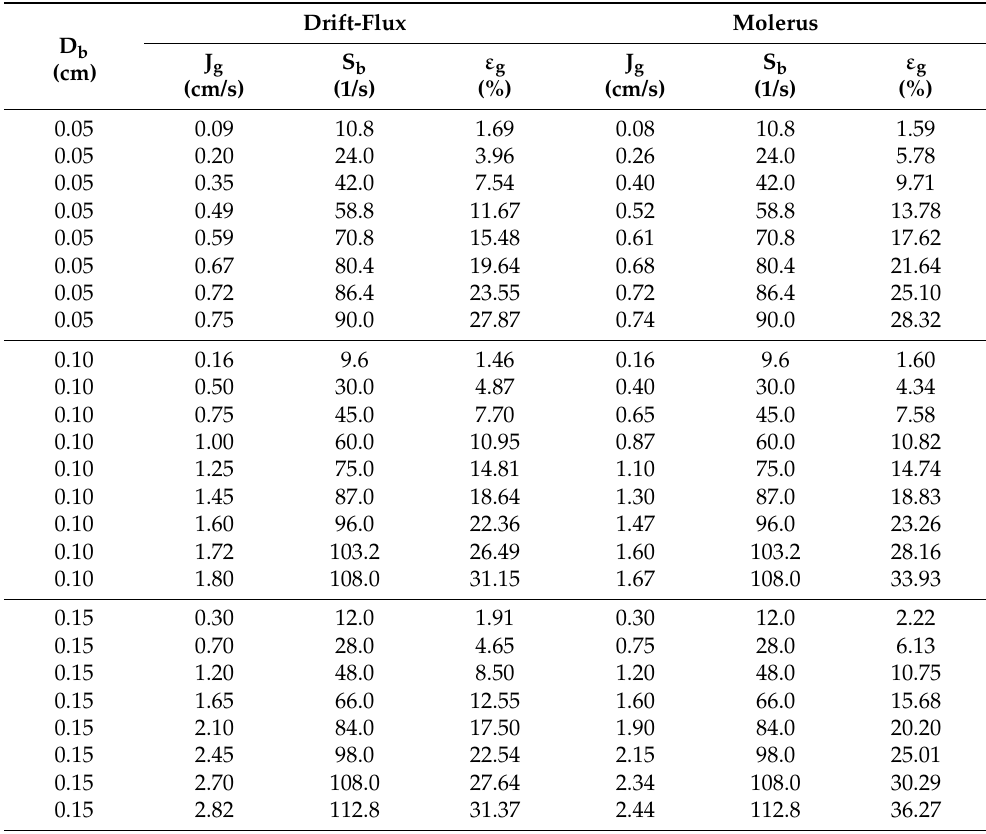
Table 1. Gas holdup model predictions for bubble sizes and gas velocities of interest in